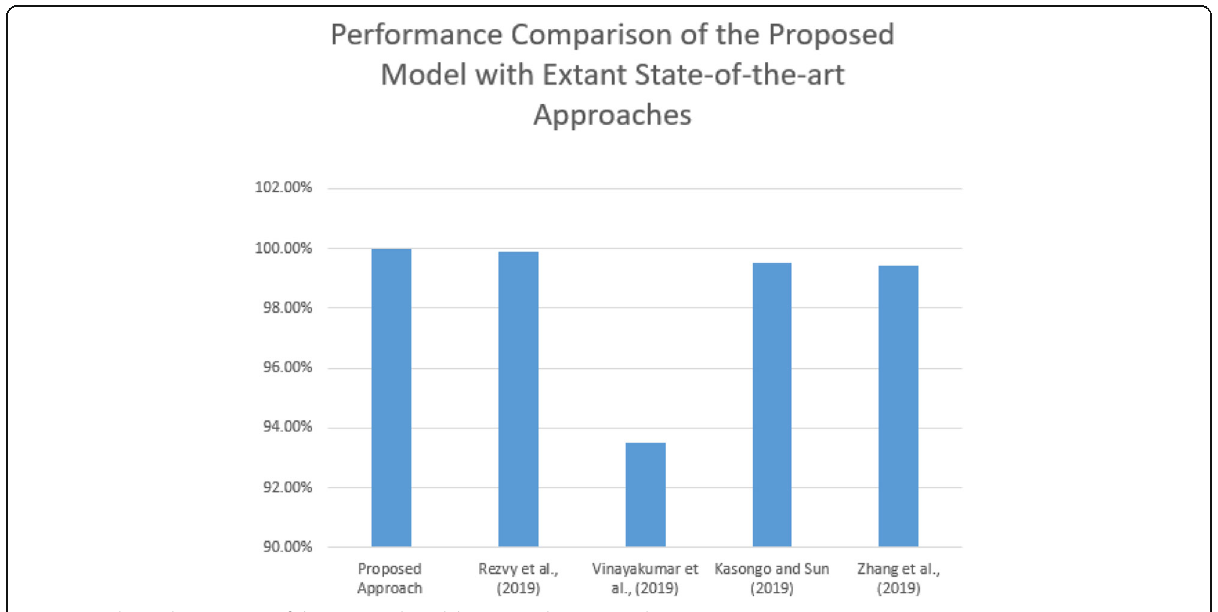
Fig. 7 Visualising the Accuracy of the Proposed Model against other Approaches